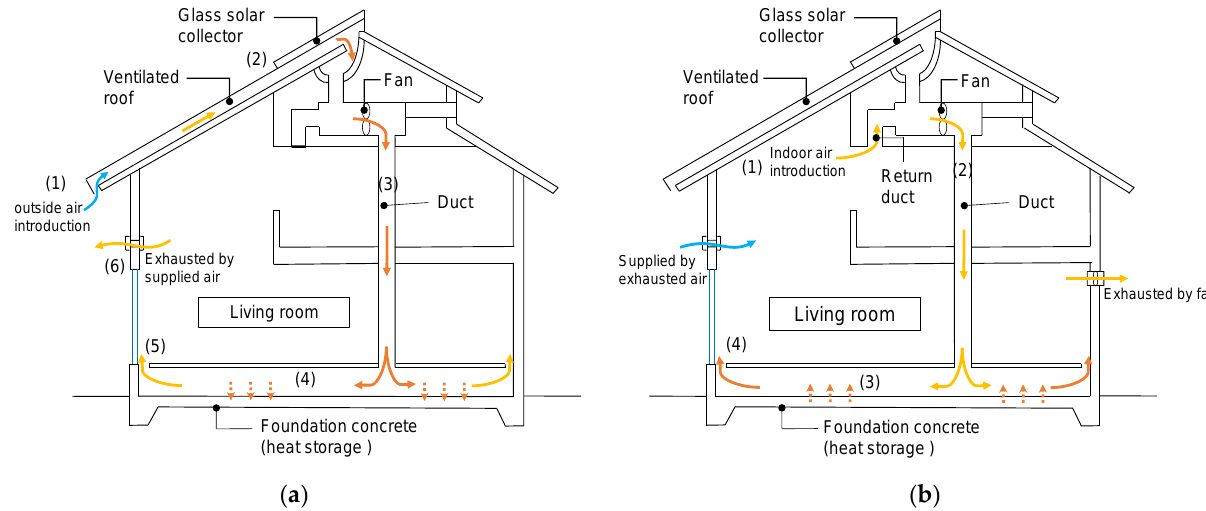
Figure 2. Air circulation route of Type N: ( a ) heat collection operation during daytime; ( b ) heat release during nighttime.